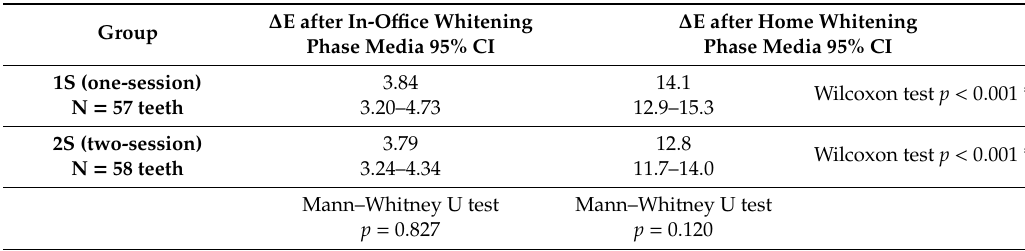
Table 2. ∆ E after in-o ffi ce and home whitening according to the number of in-o ffi ce sessions (one or two).